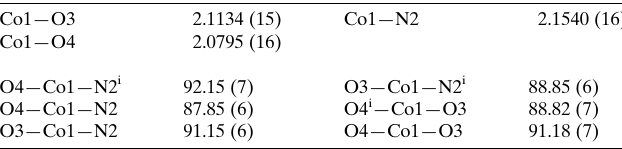
Table 1 Selected geometric parameters (A˚ , (cid:5) ).